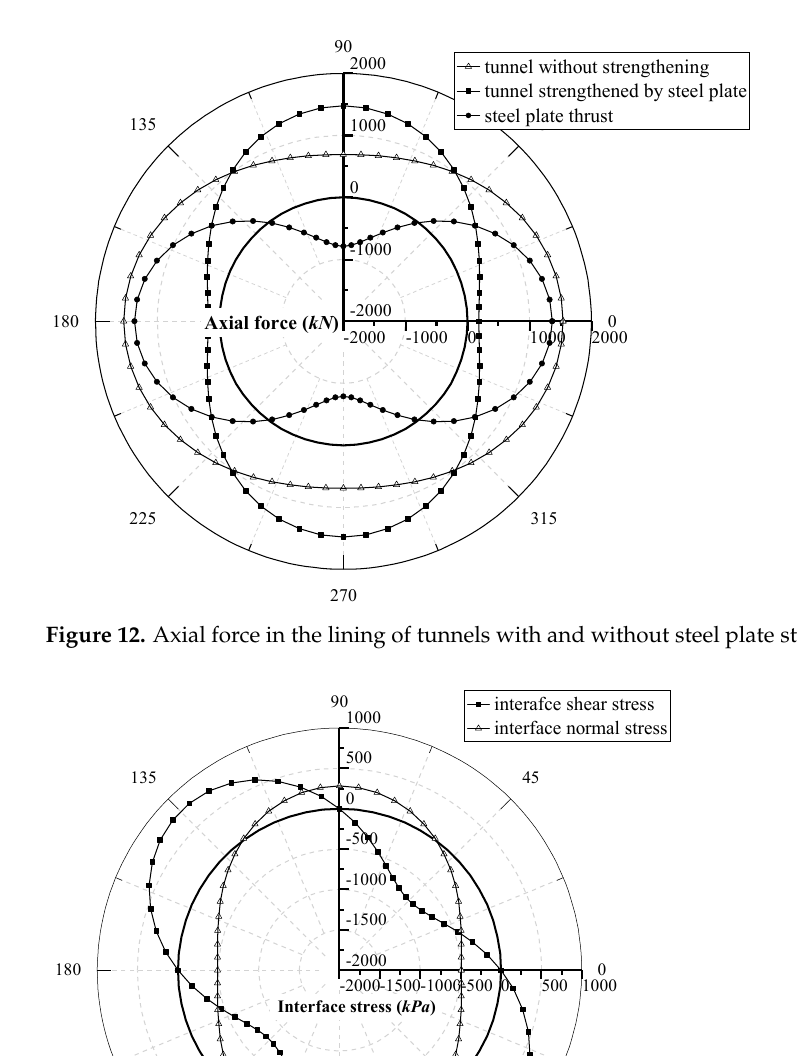
18 of 25 Figure 11. Comparison of moment in the concrete lining of tunnels with and without steel plate strengthening.